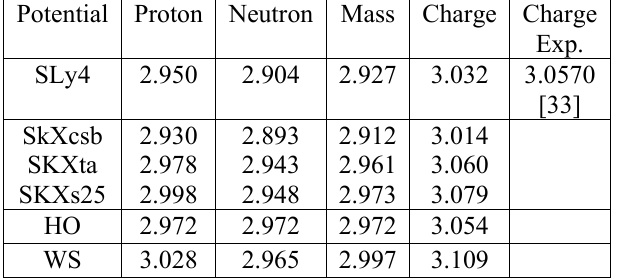
Table 1: Rms radii (fm) for 24 Mg nucleus using different single- particle potentials.